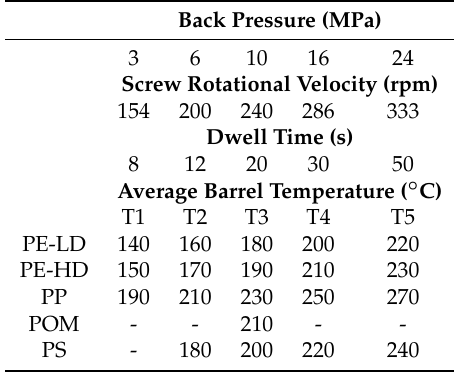
Table 3. Adjustable parameters of the injection moulding process.